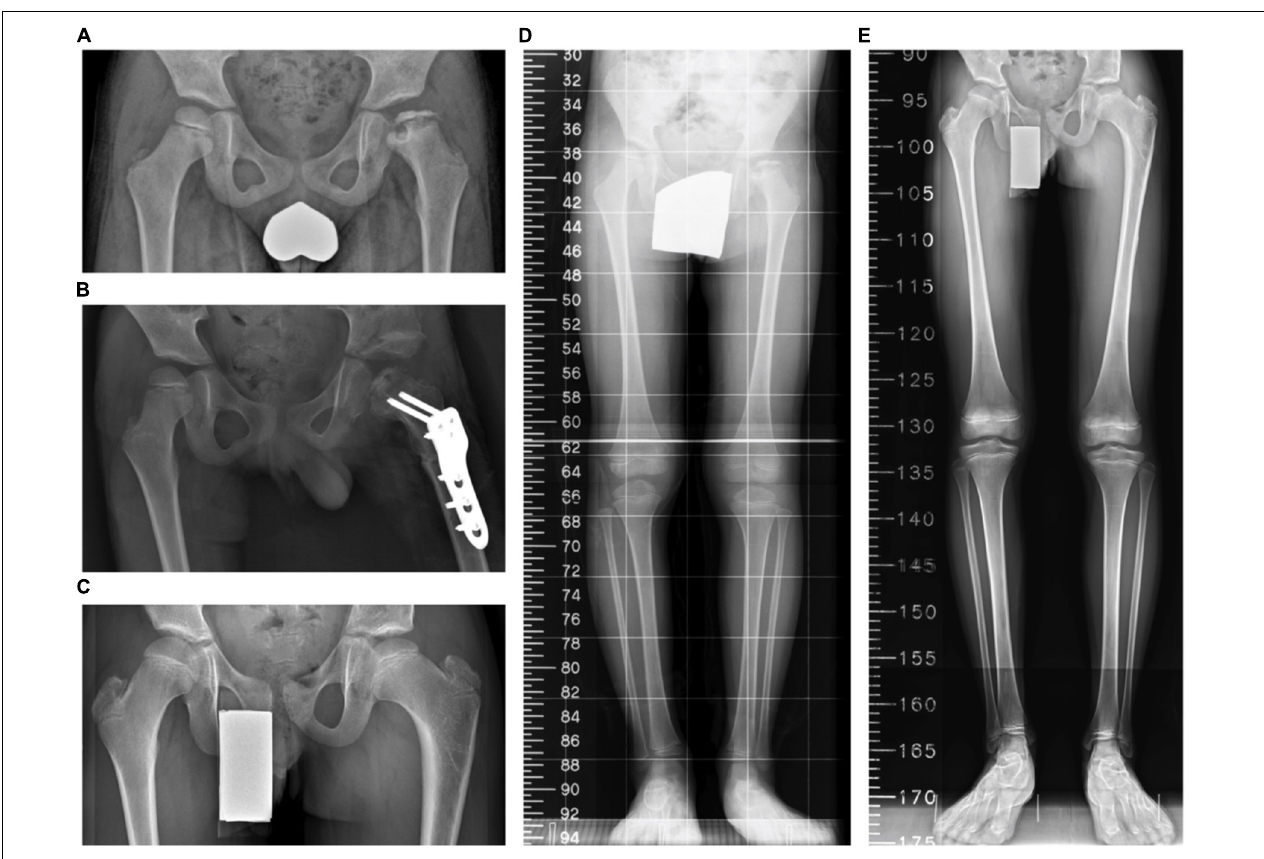
FIGURE 3 | A boy aged 6 years 4 months with Legg–Calvé–Perthes disease (LCPD) who underwent the index procedures. (A) A preoperative standing anteroposterior pelvis view. (B) A postoperative anteroposterior pelvis view. (C) The latest standing anteroposterior pelvis view 76 months after the operation. (D) A preoperative scanogram. (E) The latest scanogram 76 months after the operation.